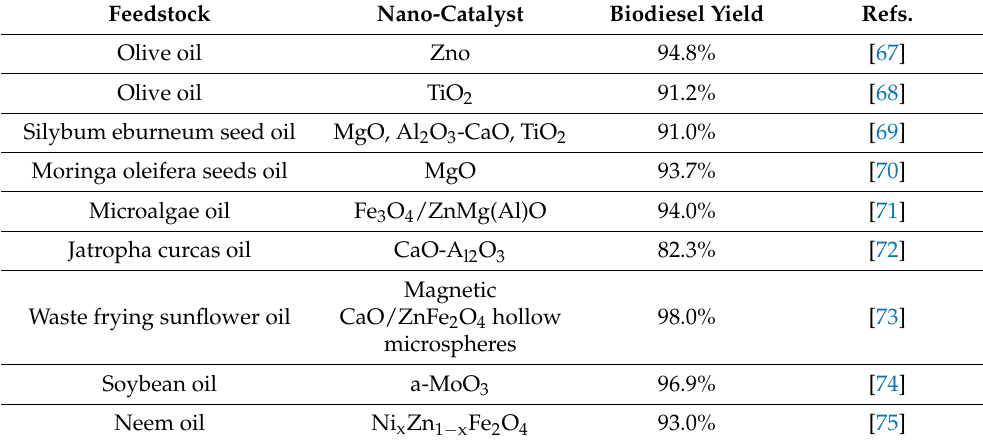
Table 1. Various feedstocks and nanocatalysts for biofuel production.